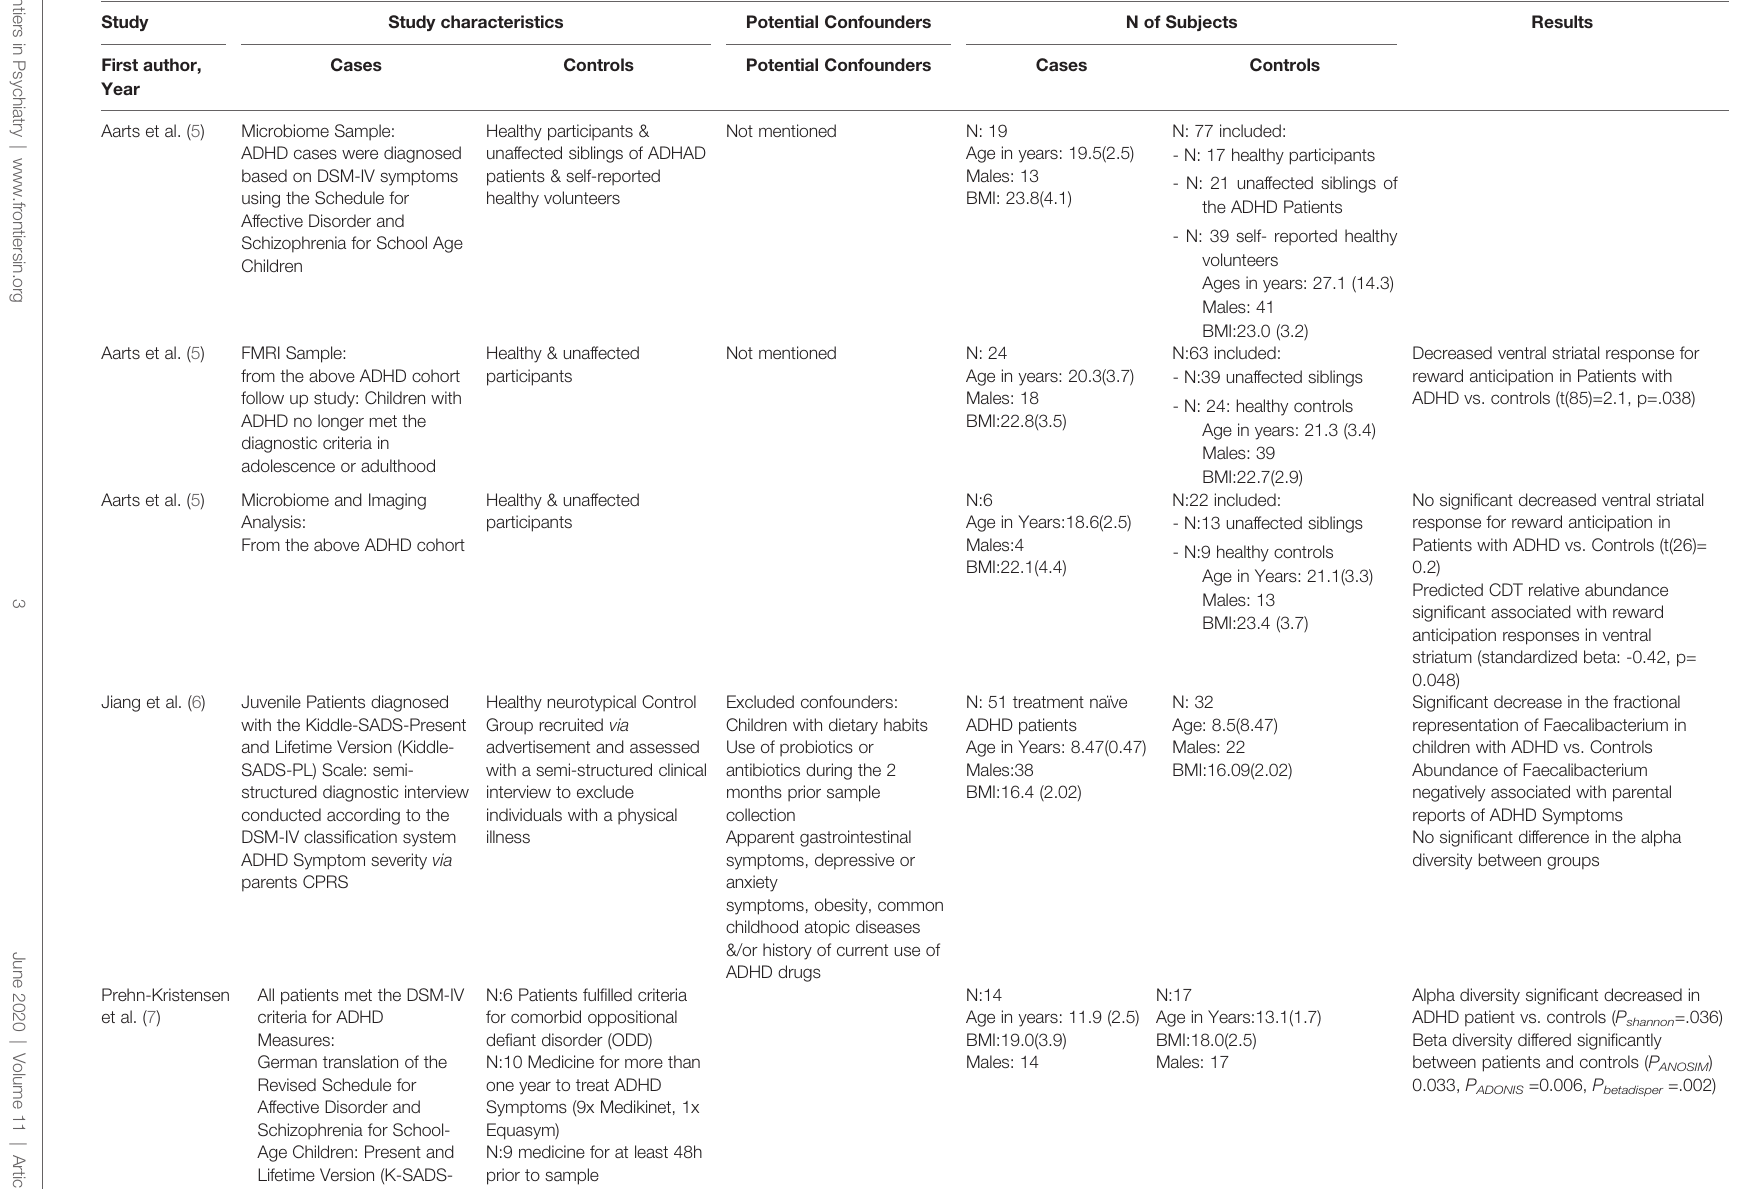
TABLE 1 | Characteristics of included